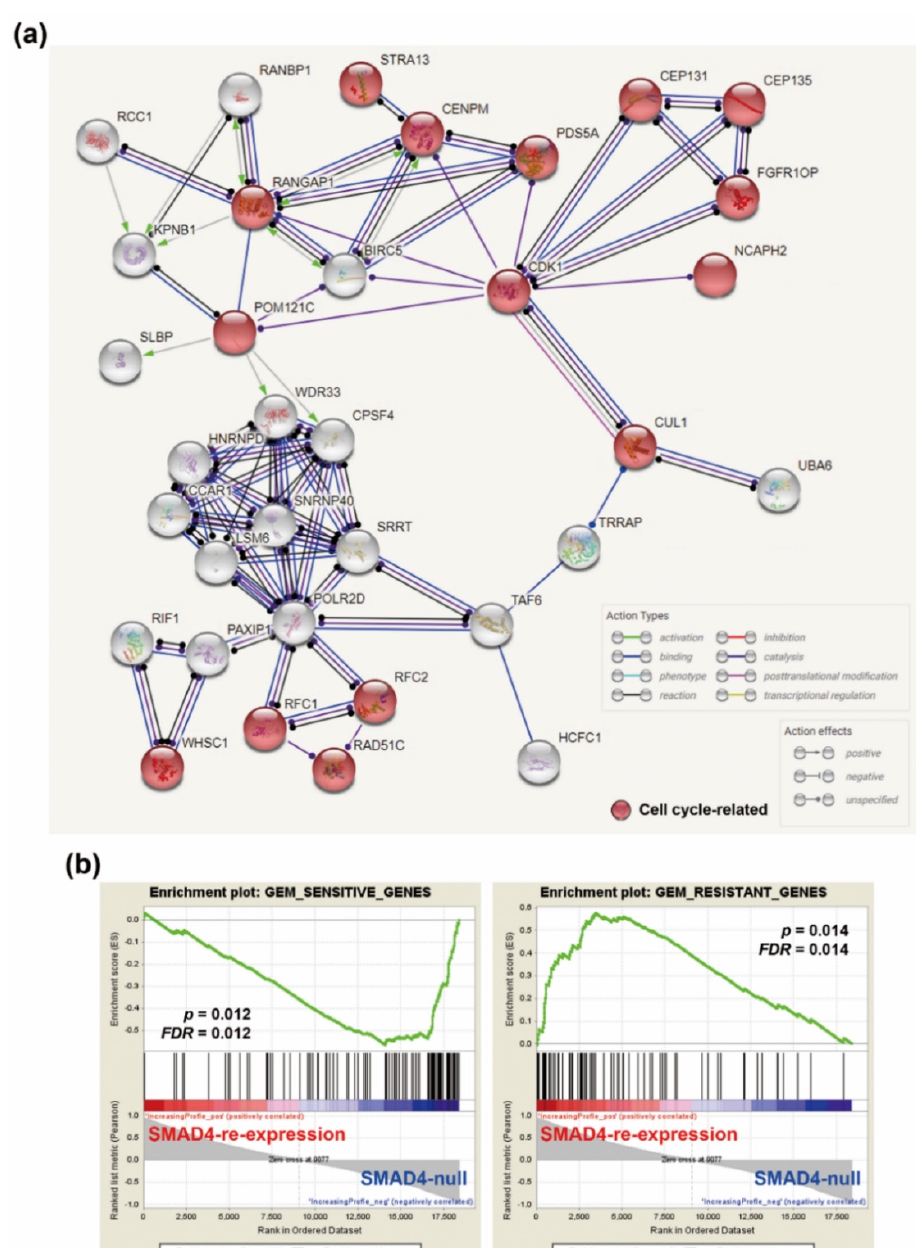
Figure 5. Gemcitabine-sensitive genes were closely associated with CDK1 and SMAD4 gene deletion in PDAC. ( a ) The network between CDK1 and gemcitabine-sensitive genes was constructed using the STRING database; ( b ) GSEA was performed to analyze the correlation between gemcitabine-sensitive/resistant genes and SMAD4 gene expression.